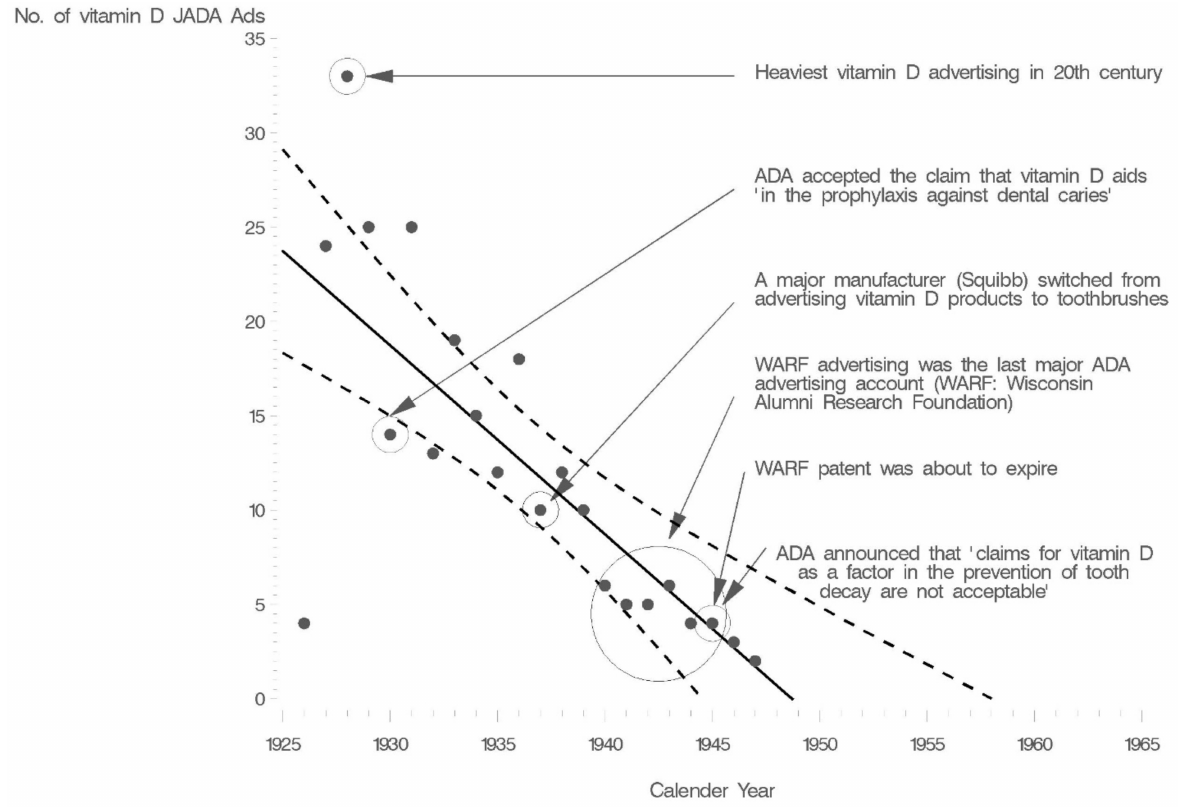
Figure 3. The ADA endorsed vitamin D dental caries prophylaxis in 1930 when vitamin D advertising revenues were high and when the Medical Research Council in the United Kingdom (UK) still considered the evidence untrustworthy. This endorsement reversed in 1945 when ADA vitamin D advertising revenues were about to go extinct but when the US National Research Council started to consider the evidence trustworthy